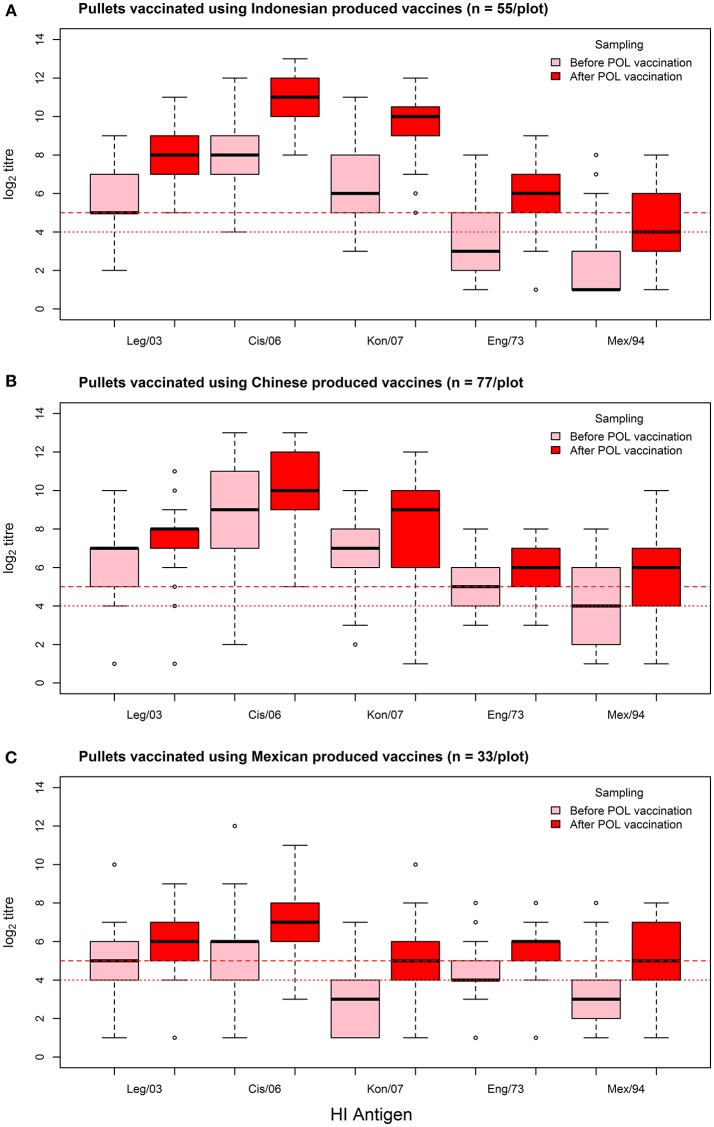
Box-plots of individual bird log2 titer responses against the panel of HI test antigens for the sampling before and after the POL vaccination, grouped according to the country of origin of the POL vaccine: (A) Indonesian vaccines, (B) Chinese vaccines, and (C) Mexican vaccines. Threshold titres for partial (1:24) and full sero-protection (1:25) are indicated with red dotted and red dashed lines respectively.